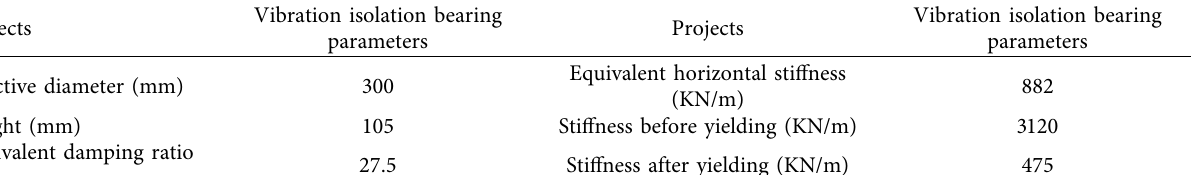
Table 3: Seismic isolation bearing parameters.